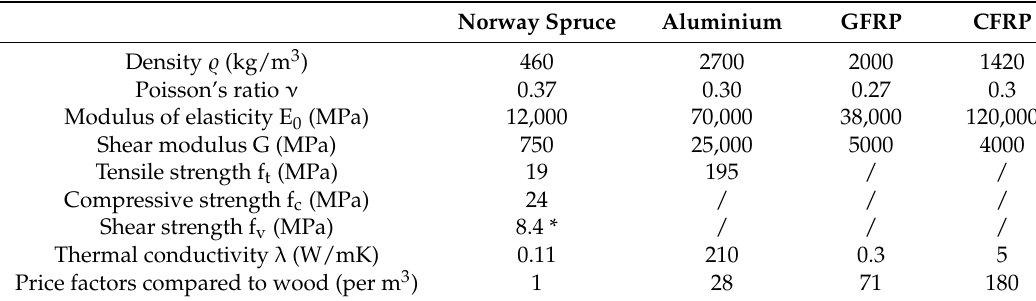
Table 1. Material